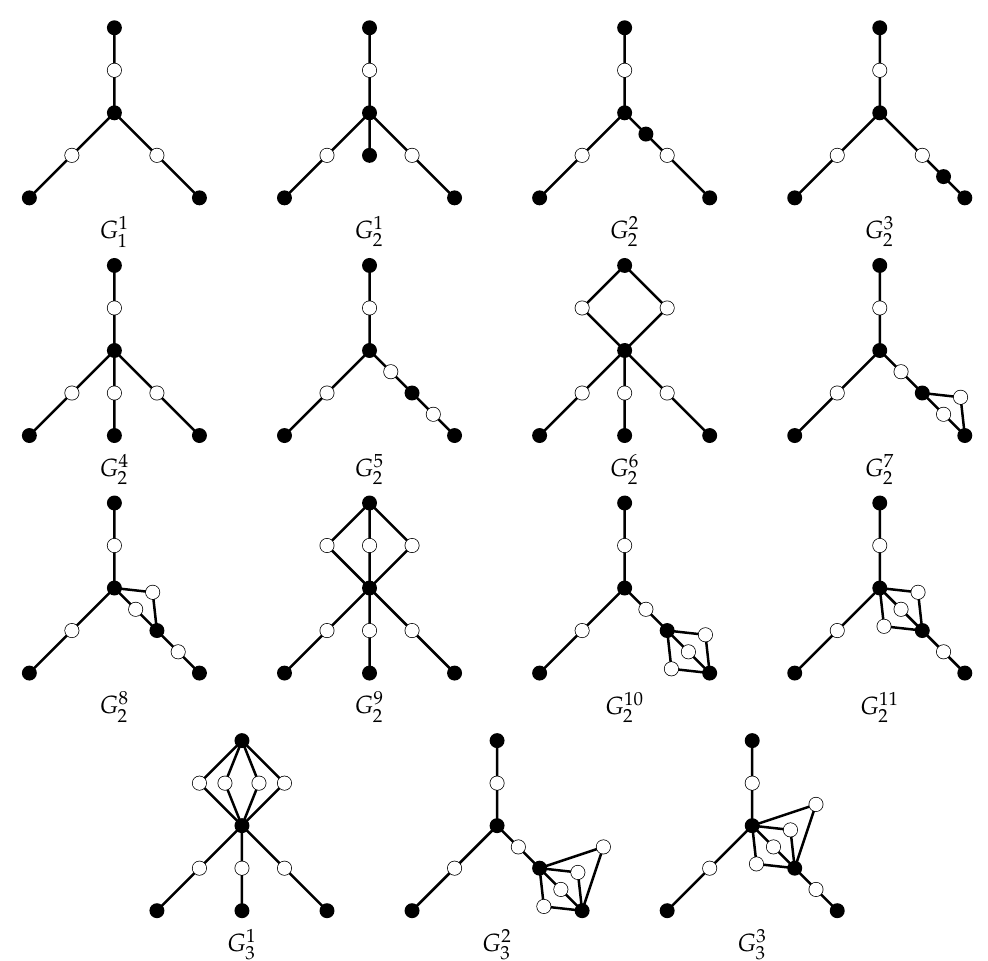
Figure 1. The family of F p for p = 8,9,10 and 11 in Theorem